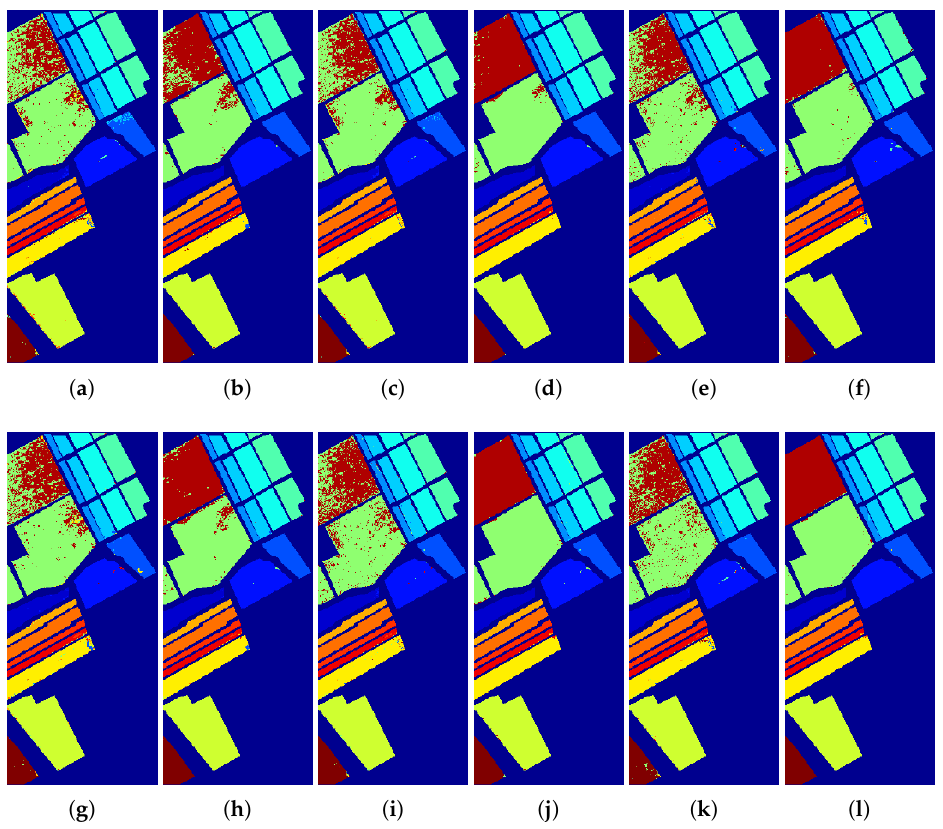
Figure 17. Classification maps of the ( a ) ELM, ( b ) ELM + GFFPC, ( c ) KELM, ( d ) KELM + GFFPC, ( e ) KSVM, ( f ) KSVM + GFFPC, ( g ) CNN, ( h ) CNN + GFFPC, ( i ) MELM, ( j ) MELM + GFFPC, and the proposed ( k ) DKELM, and ( l ) DKELM + GFFPC for the Salinas dataset